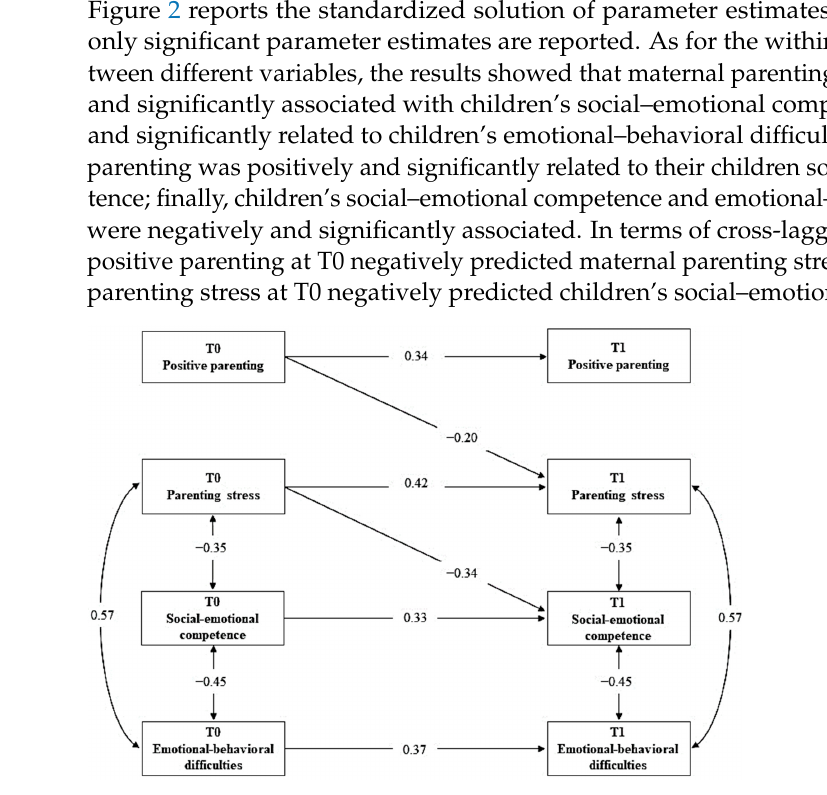
Figure 2. Statistical autoregressive cross-lagged model. Standardized solution.